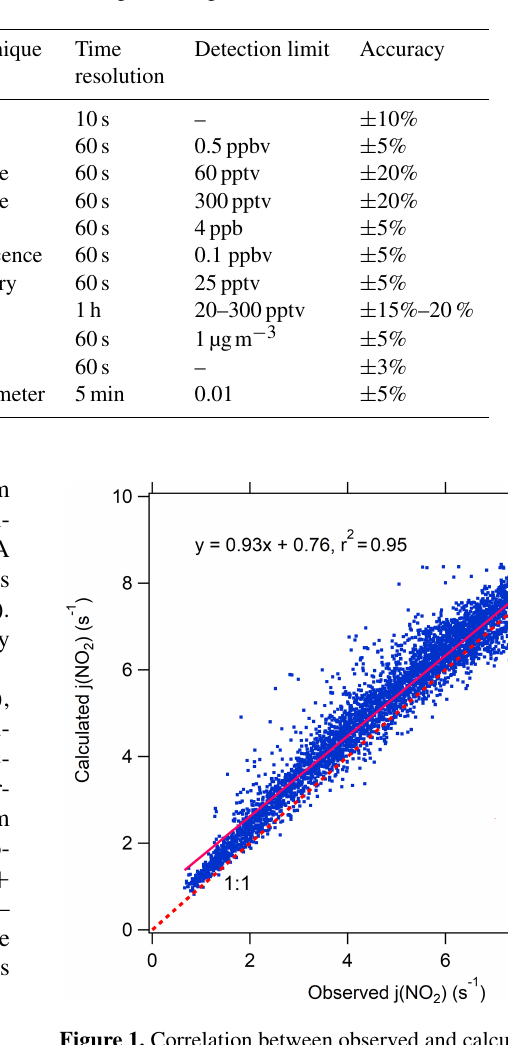
Figure 1. Correlation between observed and calculated J( NO 2 ) by the TUV model in Beijing in summertime during